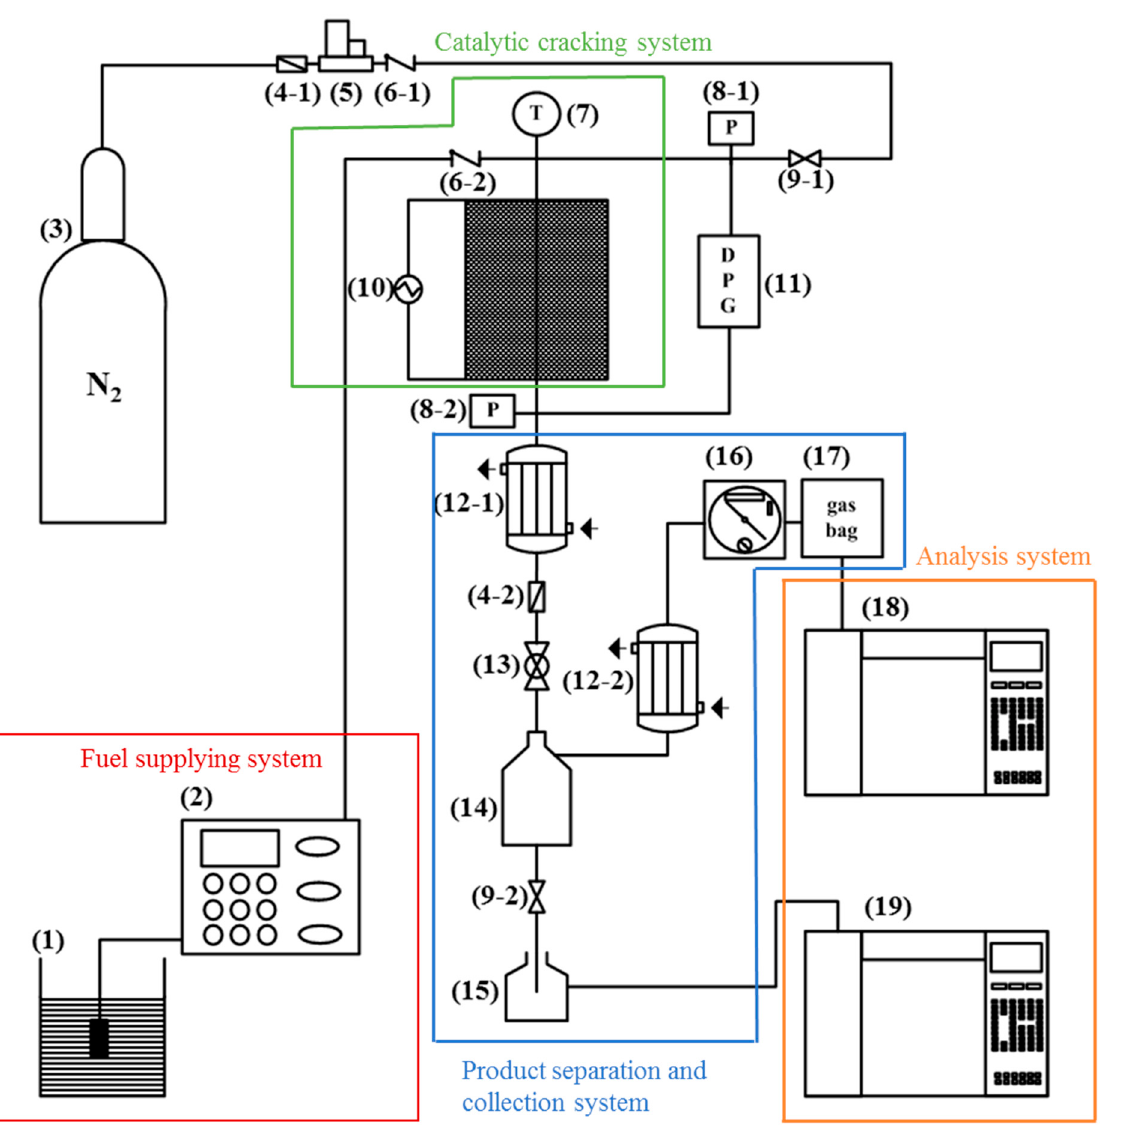
Figure 12. Experimental setup for the catalytic cracking of n -dodecane: (1) fuel container, (2) dosing pump, (3) N 2 gas cylinder, (4) gas filter, (5) mass flow controller, (6) check valve, (7) K-type thermocouple, (8) pressure gauge, (9) on/off valve, (10) electrical heater, (11) differential pressure gauge, (12) water condenser, (13) back-pressure regulator, (14) gas-liquid separator, (15) liquid collecting vial, (16) wet gas meter, (17) gas collecting bag, (18) gas chromatograph for analysis of gaseous products, and (19) gas chromatograph for analysis of liquid products.